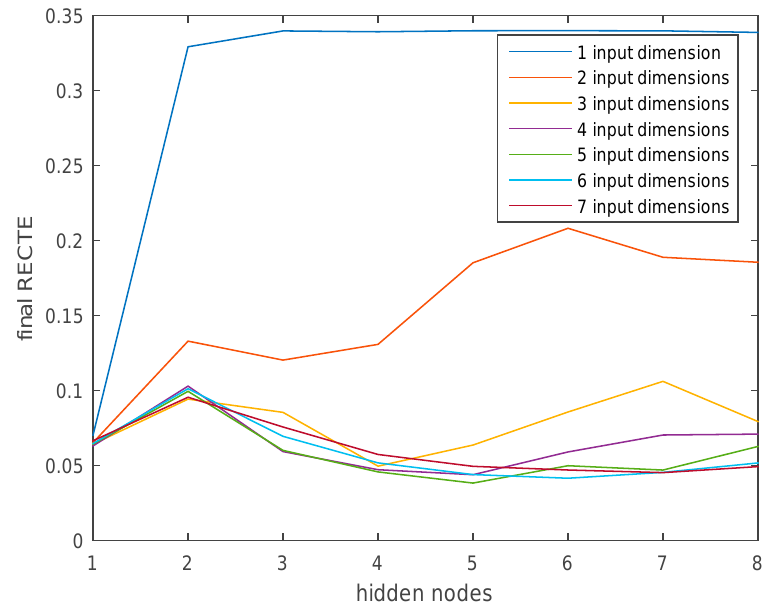
Figure 4. The relative error of changing time estimation (RECTE) of different input dimensions and hidden nodes.